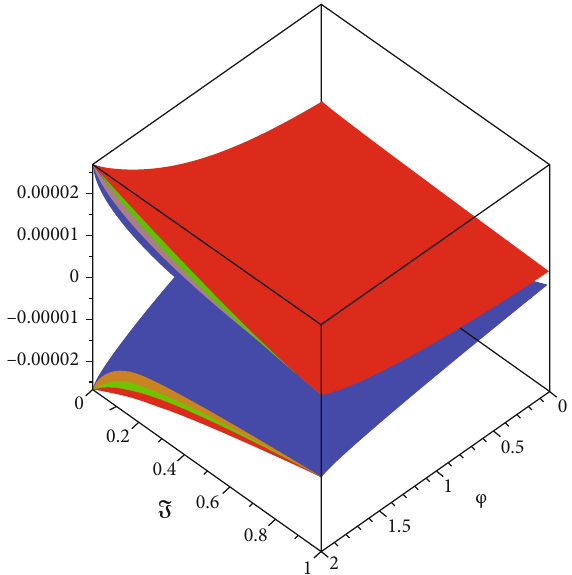
Figure 3: The three-dimensional fuzzy lower and upper branch graph of the di ff erent fractional-order of ϱ .